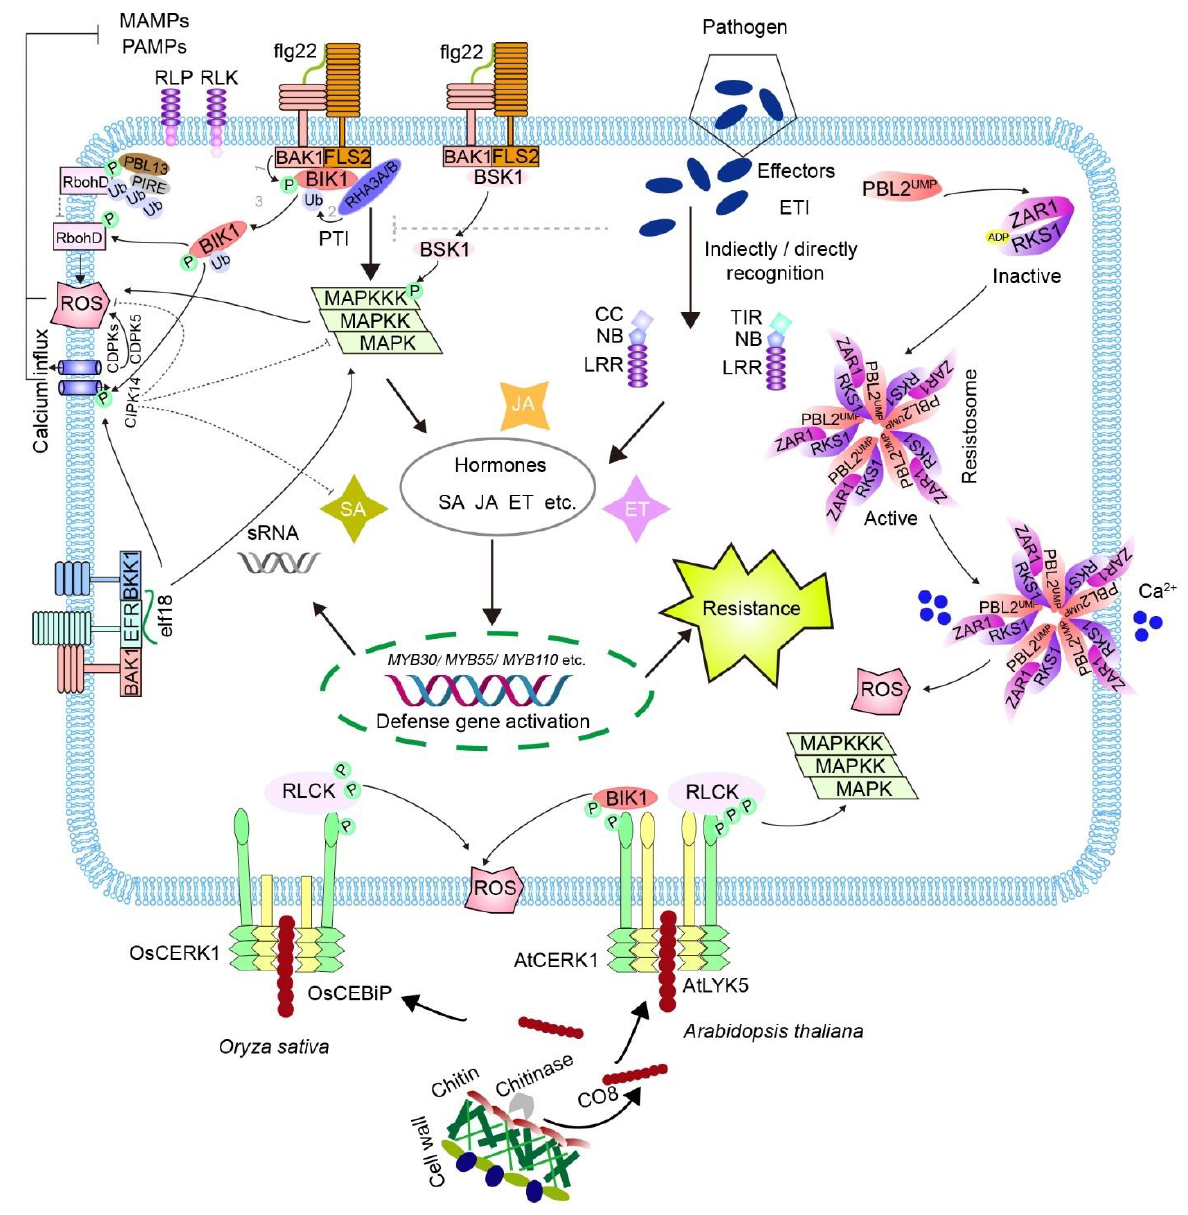
Figure 1. Schematic summary of plant innate immune signaling pathways. MAMPs, sensed by membrane-localized PRRs which work with RLCKs, trigger immune responses, which typically involve MAPK cascades, a ROS burst, a Ca 2+ influx, and upregulation of transcription factors such as MYB30, MYB55, and MYB110 to induce defense gene expression. For example, upon flg22 detection, BIK1 is phosphorylated by FLS2-BAK1, followed by monoubiquitination by RHA3A/B and then dissolution from the FLS2-BAK1 complex to phosphorylates RbohD to promote ROS production and cyclic nucleotide-gated channels to increase the concentration of cyclic calcium. ROS production is negatively regulated by the PBL13-PIRE complex which phosphorylates and ubiquitinates RbohD. Additionally, BSK1 disassociates from the FLS2-BAK1 complex when flg22 is detected and subsequently phosphorylates MAPKKK to induce downstream signals. In addition, Ca 2+ -dependent kinases (CDPKs), such as CDPK5, have been shown to be involved in PTI by activating NADPH oxidases. However, another Ca 2+ sensor, CBL-interacting protein kinase 14 (CIPK14), negatively reg- ulates MAPK-mediated immune responses and SA production. Furthermore, the EFR/BAK1/BKK1 complex shares common signaling pathways with FLS2 in response to elf18. In addition, fungal